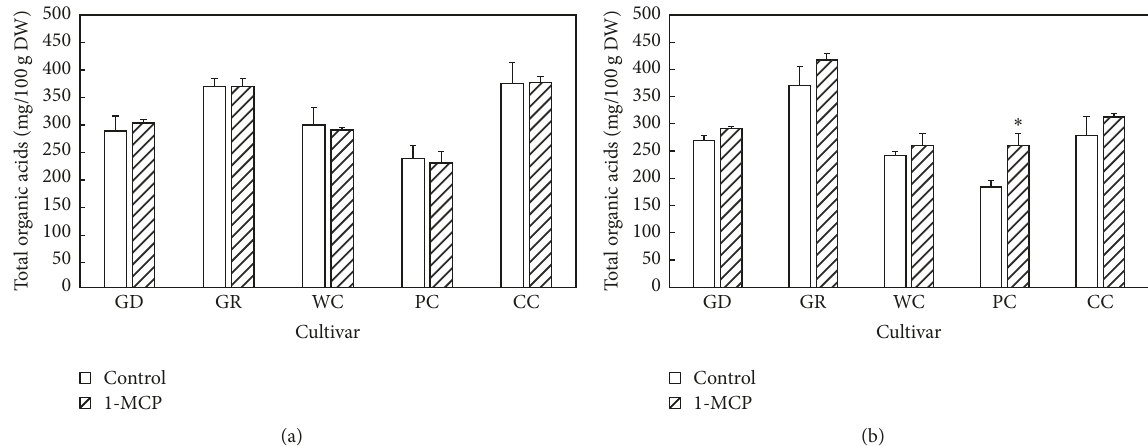
Figure 2: Total organic acid content in apple fruit at (a) 70 or (b) 140 days of storage at 0 ∘ C followed by 7 days at 20 ∘ C. GD, “Golden Delicious”; GR, “GoldRush”; WC, “WineCrisp”; PC, “Pixie Crunch”; CC, “CrimsonCrisp.” Asterisks ( ∗ ) indicate significant difference between control and 1-MCP treatment in each cultivar at each storage duration treatment by Student’s 𝑡 -test at 𝑝 < 0.05 . Vertical bars represent standard error ( 𝑛 = 4